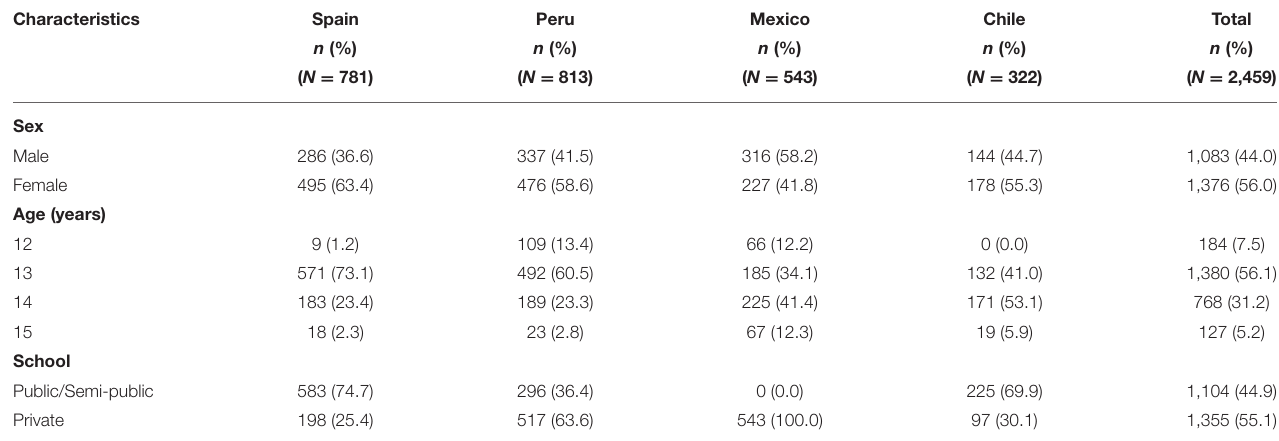
TABLE 1 | Main characteristics of participants. Characteristics